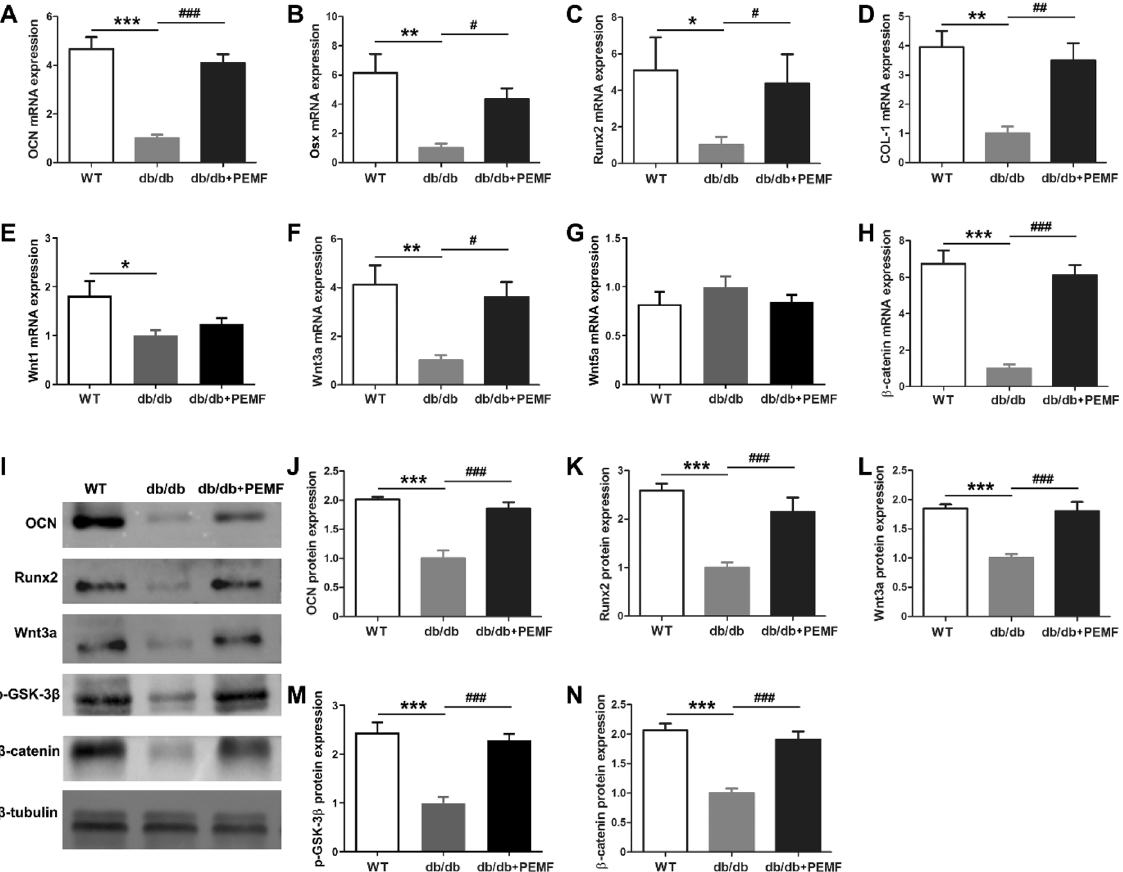
Figure 4. Pulsed electromagnetic fields (PEMF) exposure increases the expression of osteoblastic differentiation markers and stimulates the activation of Wnt3a/β-catenin signaling in primary osteoblasts in vitro isolated from mandibular bone of db/db mice. ( A–D ) Analysis of in vitro osteoblastic differentiation- related gene expression, including osteocalcin (OCN), Runx2, Osx and COL-1. (E–H) Analysis of in vitro gene expression of canonical Wnt1 and Wnt3a ligands, non-canonical Wnt5a ligand, and downstream β-catenin of canonical Wnt signaling in primary osteoblasts. (I–N) In vitro protein expression analysis of OCN, Runx2, Wnt3a, p-GSK-3β and β-catenin in primary osteoblasts based on western blotting assays. Data are represented as mean ± SEM ( n = 7–10/group). * P < 0.05, ** P < 0.01, *** P < 0.001 vs. the WT group; # P < 0.05, ## P < 0.01, ### P < 0.001 vs. the db/db group by one way analysis of variance (ANOVA) followed by Bonferroni’s multiple